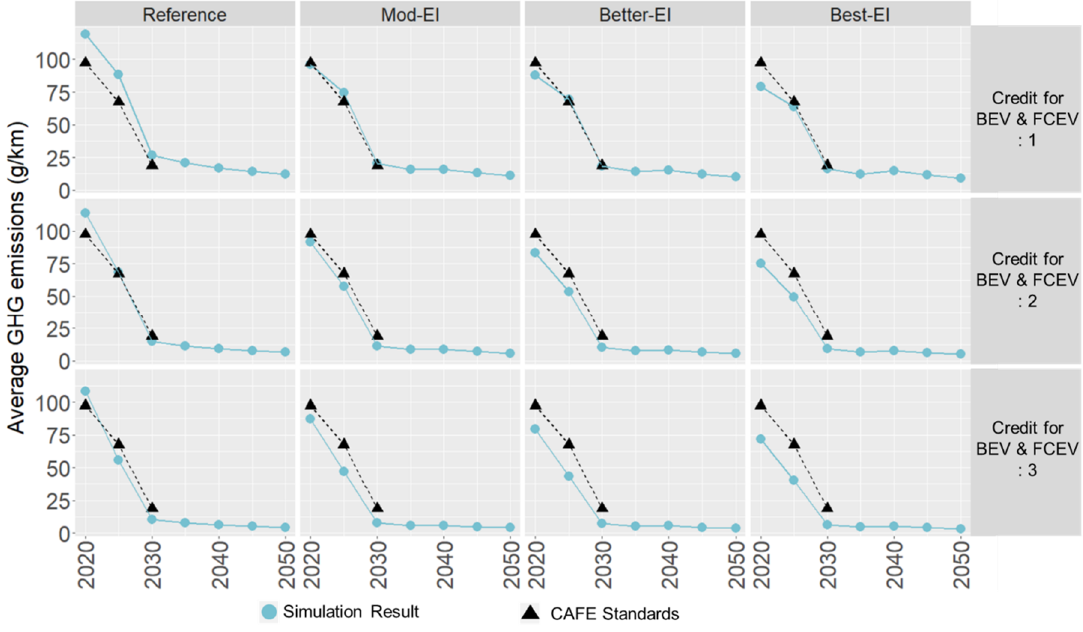
Figure 9. Average greenhouse gas (GHG) emissions by scenarios and the degree of credit for BEVs and FCEVs.